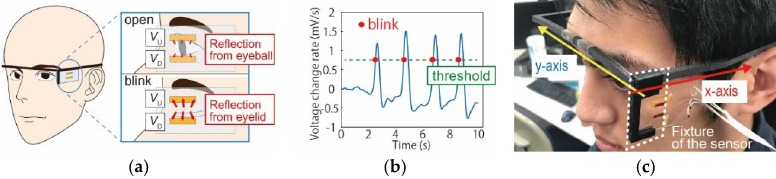
Figure 1. Smart glass system to detect blinks. ( a ) Schematic view of the sensor cells. Two dye-sensitized photovoltaic cells were patterned on a glass substrate as the optical sensors, which detect the reflection light from the eye. The reflection light from the eyelid when the subject blinks is larger than that from the eyeball when he/she opens the eye. ( b ) Detection of the blink. When the derivative of the average output of the two sensor cells exceeds the threshold, we consider the subject to be blinking. ( c ) Position of the system. The positions in the x - and y -axes can be varied by the location to set the fixture onto the temple and by the holder design, respectively.